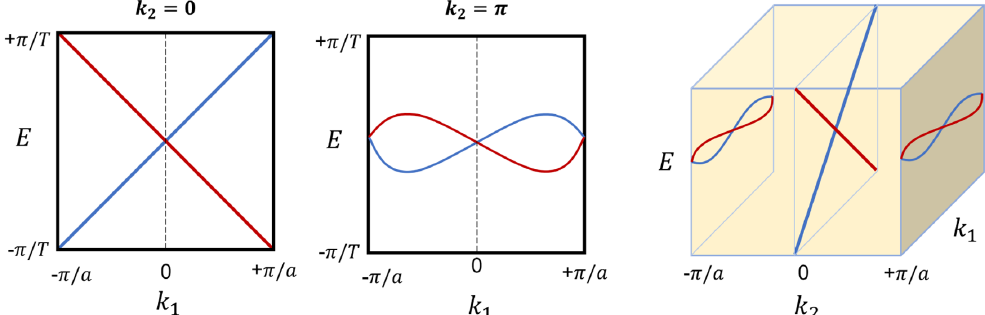
FIG. 4. Dispersion relations of the quasienergy spectrum of the two-band model along the high-symmetry lines k 2 ¼ 0 (left panel) and k 2 ¼ π (middle panel), respectively (see also discussion in the main text). The former contributes to the topological invariant by the factor Pf ½ w Λ (cid:3) Pf ½ w Λ (cid:3) ¼ − 1 , while the latter gives the factor Pf ½ w Λ 1 2 Right panel: visualization of dispersions along the high-symmetry lines in the 2 D Brillouin